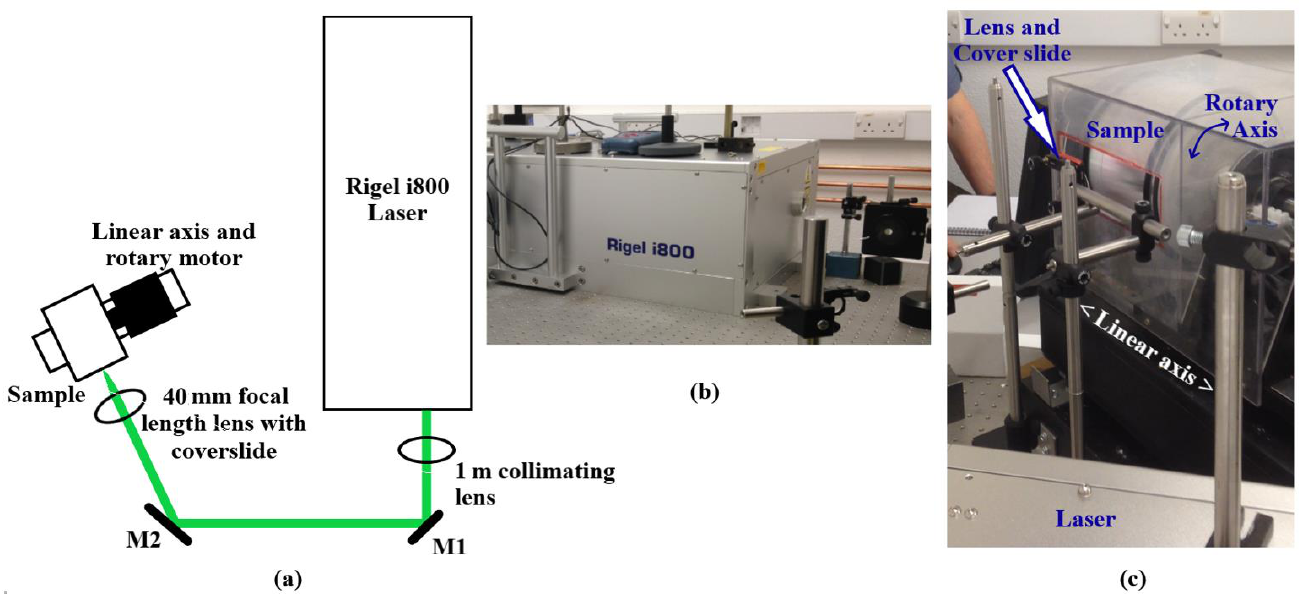
Figure 1. Laser Texturing Set up: ( a ) Schematic of high-speed laser texturing setup; ( b ) output (image) from Rigal i800 laser; ( c ) high speed rotary axis .